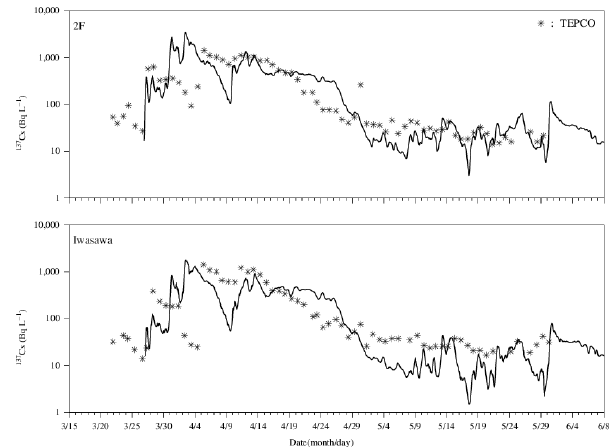
Fig. 5. Comparisons of model-computed and observed 137 Cs concentrations at 1F-N and 1F-S over the period 26 March– 8 June 2011.